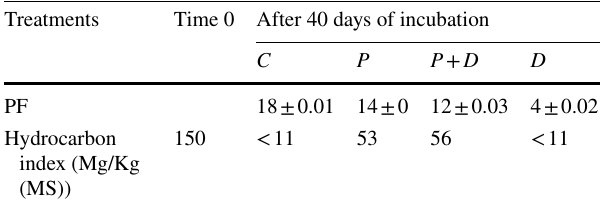
Table 6 Effects of petroleum dispersion on the biodegradation